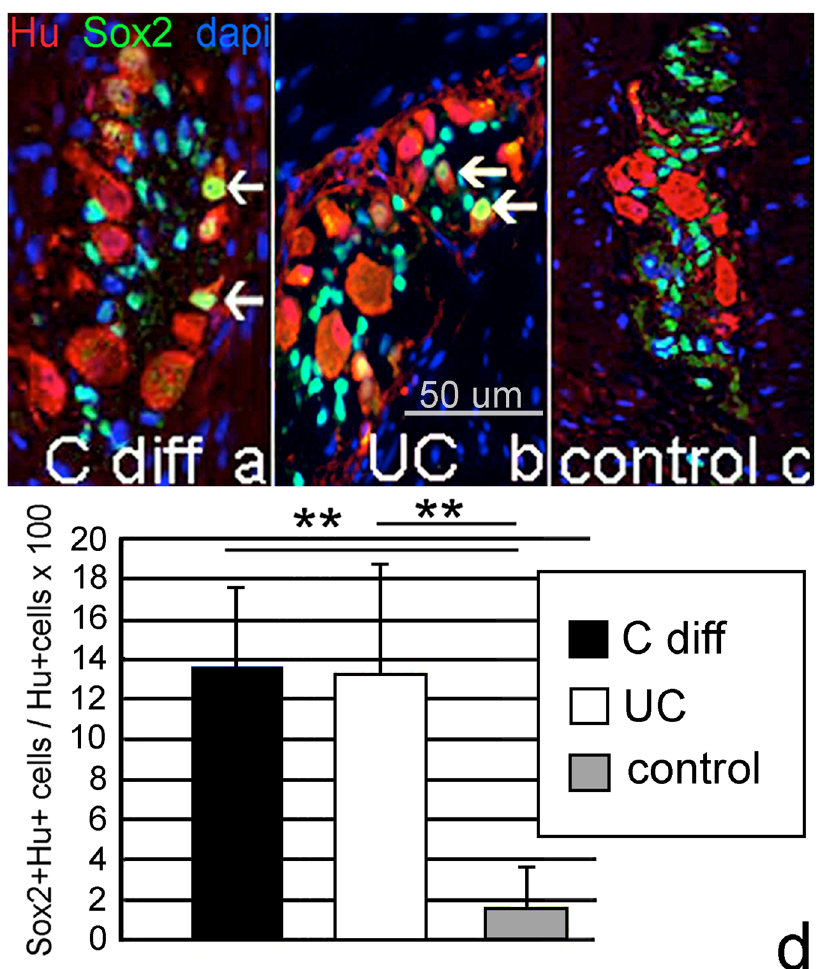
Figure 9. Infectious and inflammatory colitis in humans leads to an expansion of Sox2 + Hu + neurons. Patients with Clostridium difficile (n = 15) ( a ) or ulcerative colitis (n = 15) ( b ) have significantly more Sox2 + Hu + neurons than control colon ( c ), where Sox2 + Hu + neurons are infrequently observed ( d ). (All Images were taken at